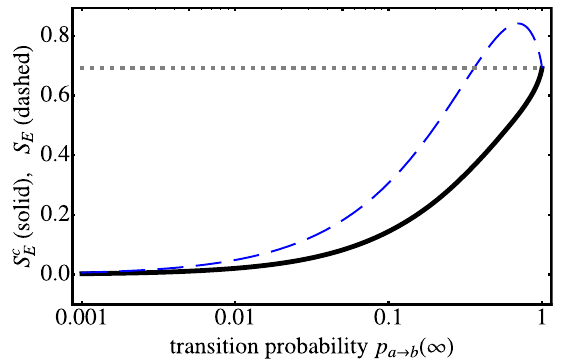
Fig. 2 Entropy of the environment. The classical contribution to the environment entropy, S c E ð1Þ , increases monotonically as a function of the transition probability from a j i to b j i , p a → b ( ∞ ) (solid black), providing an additional signature of the dissipative adaptation. The environment entropy, S ∞ ), presents a non-monotonic behavior as a function of p E ( (dashed blue), due to a sustained system – environment quantum entanglement that can contribute to the entropy production of the environment. In both curves, we refer to the asymptotic state t → ∞ of the dynamics. We use Γ a = Γ b as the environment-induced spontaneous emission rates and p ð 0 Þ a ¼ p ð 0 Þ b ¼ 1 = 2 as the probabilities in the initial state of the lambda system, ρ S ð 0 Þ ¼ p ð 0 Þ a a j i a h j þ p ð 0 Þ b b j i b h j (the curves do not qualitatively depend on these choices). The dotted gray line is ln ð 2 Þ . Note that both S c E ð1Þ as a function of p a → b ( ∞ ) and S E ( ∞ ) as a function of p ∞ ) do not explicitly depend on the photon pulse shape, though a → b ( p a → b ( t ) does; e.g., attaining p a → b ( ∞ ) → 1 requires an extremely monochromatic (long) photon, whereas the p a → b ( ∞ ) → 0 limit is attained in the extremely broadband (short) pulse